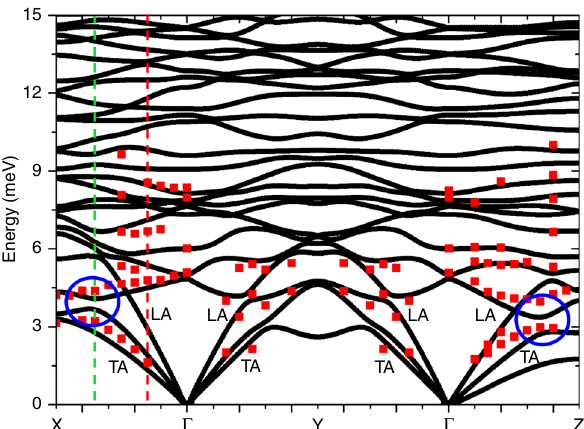
Fig. 6 DFT calculations of phonon dispersions compared to experimental excitation energies. DFT calculations of the low-energy phonon dispersion curves of [VO(acac) 2 ] up to 15 meV along the path X (0.5, 0, 0) – Γ (0, 0, 0) – Y (0, 0.5, 0) – Γ (0, 0, 0) – Z (0, 0, 0.5) (black lines), where the coordinates are expressed in the reciprocal lattice basis units. Red scatters are the energies of experimental excitations extracted by fi tting 1D cuts of the data as in Fig. 2 (error bars as SD are of the order of scatters dimension). Not all the modes are visible in the considered con fi gurations. Blue circles highlight ACs between acoustic and low-lying optical branches along Γ – X and Γ – Z . Red and green dashed lines indicate the q vectors at which we have investigated the atomic displacements far from and at the ACs,